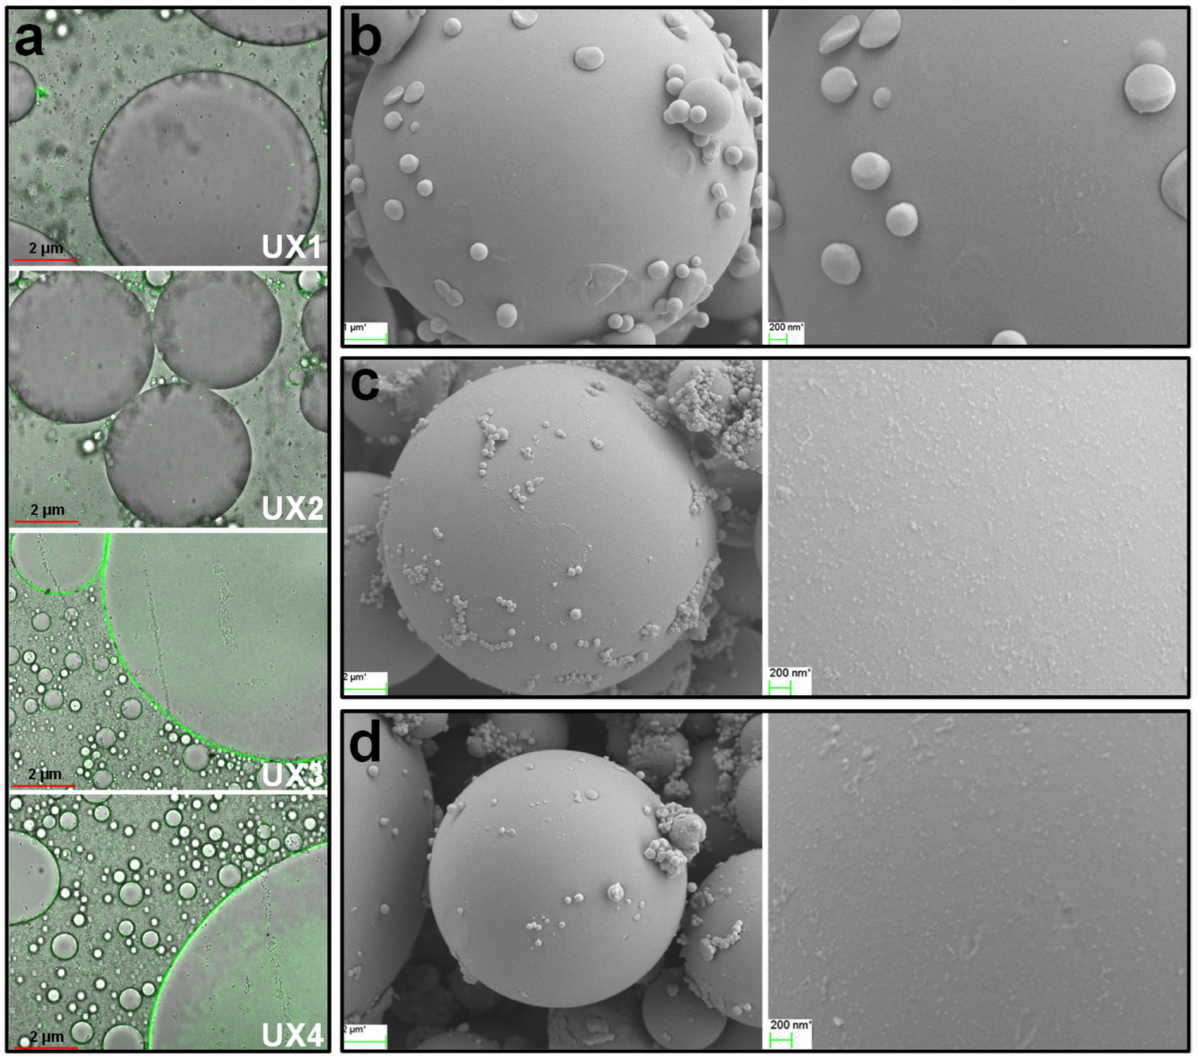
Figure 7. ( a ) Laser confocal microscope images of UX1–UX4 adsorption on the oil droplet surface. FESEM images of the rigid polystyrene droplet (produced from in situ polymerization) surface: ( b ) no emulsifier, ( c ) UX3, and ( d ) UX4 as the